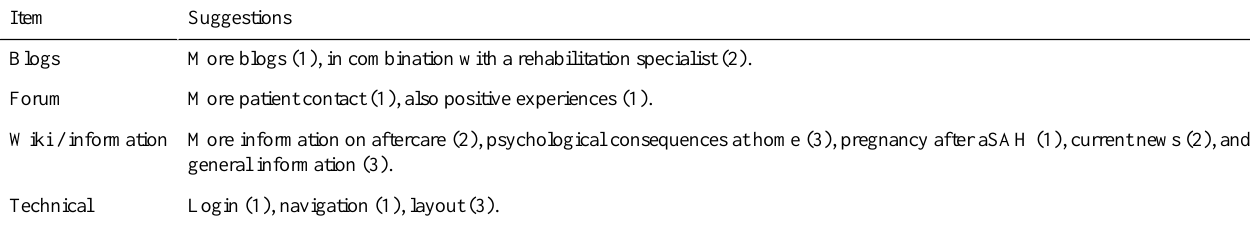
Table 2. Items for improvement a .